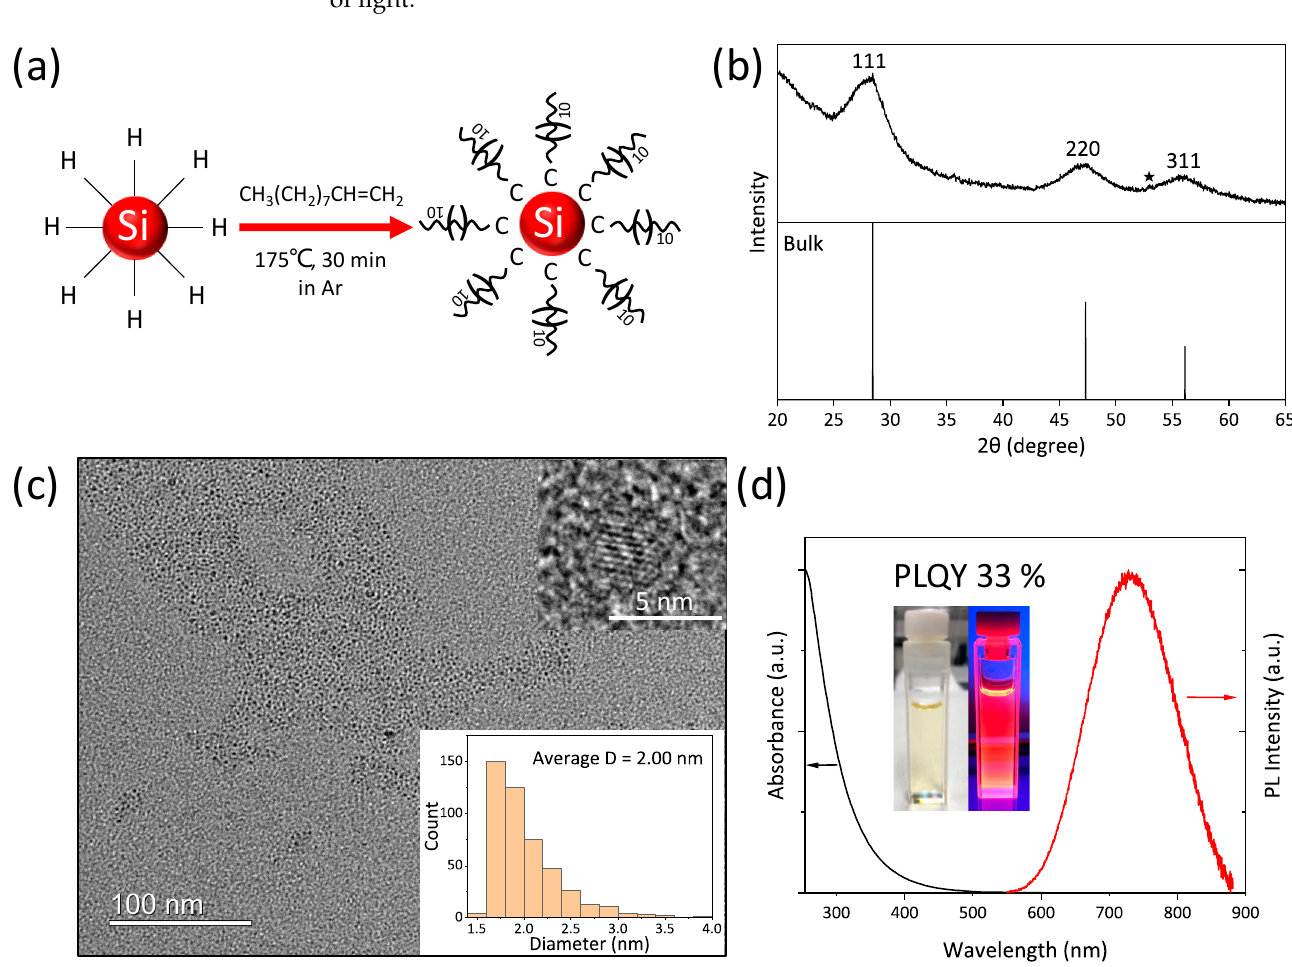
Figure 1. ( a ) Schematic illustration for preparation of the decane-terminated silicon quantum dot (De- SiQDs). ( b ) X-ray diffraction (XRD) pattern of De-SiQDs. The slight peak in near 53 degrees (shown by asterisk) is probably due to noise. ( c ) High-resolution transmission electron microscopy (HR- TEM) image with an inset of enlarged QDs and histogram of QD’s size distribution and ( d ) optical absorption and photoluminescence (PL) spectra of De-SiQDs dispersed in toluene. The inset is photographs of the toluene solution of De-SiQDs under the illumination of room light (left) and a 365-nm UV handy lamp